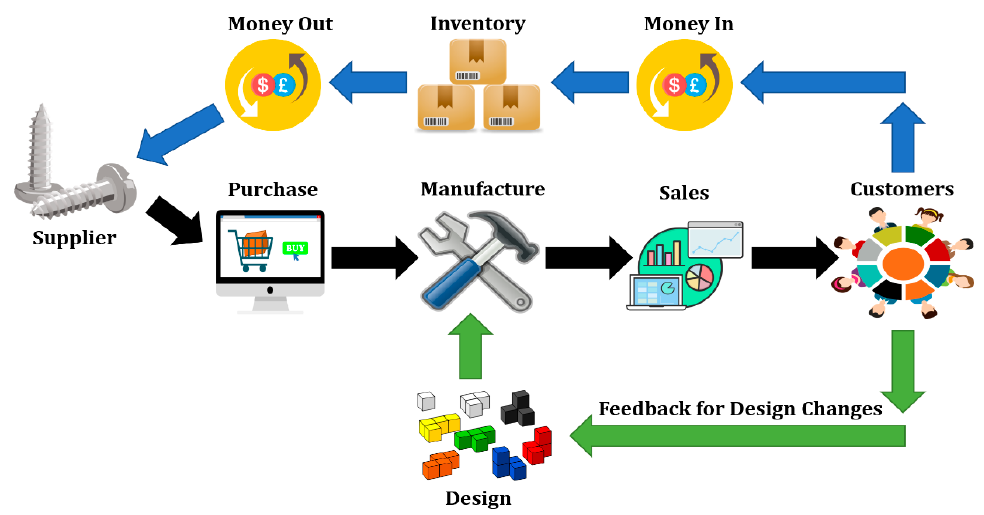
Figure 11. Relationship among different business processes.